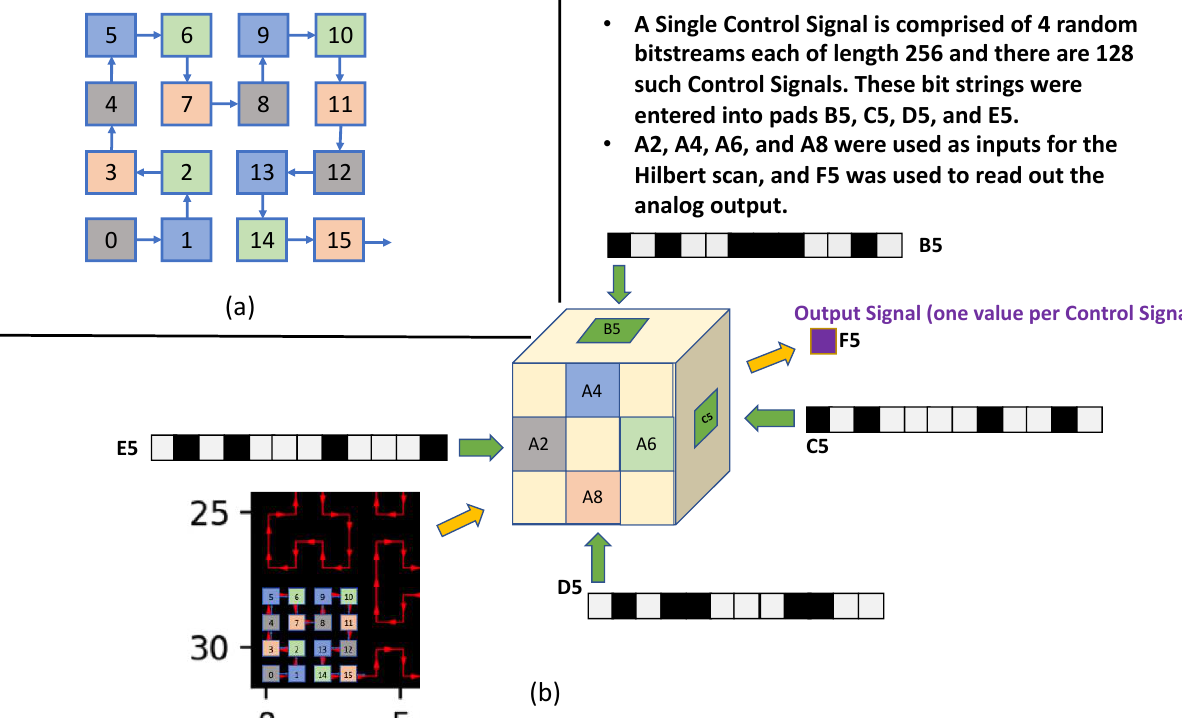
Figure 4. Panel ( a ) shows the details of scanning the Hilbert curve into face A of the cube. At time, t = 0, there are four bits of signal representing the scan at positions 0, 1, 2, and 3. Panel ( b ) shows these bits are entered into the cube at A2, A4, A6, and A8, respectively, following the color code. Additionally, random bit strings, as the control strings, are entered at B5, C5, D5, and E5 all simultaneously with the image bits and reading the output at F5.